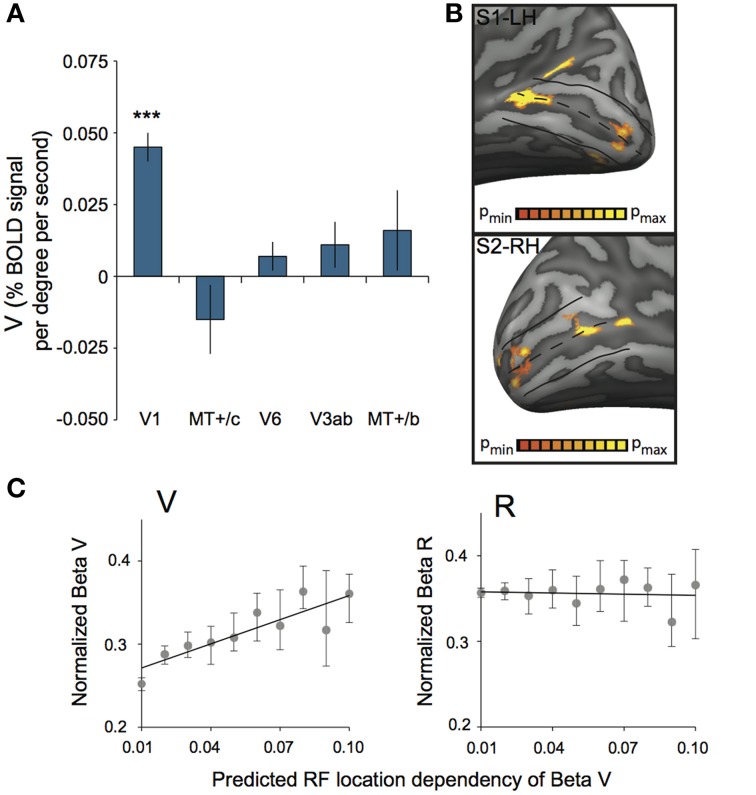
Vergence (V) response in striate cortex. (A) Sensitivity to V across subjects for each ROI. Only V1 was modulated strongly by V (***p < 0.001). (B) V activation plotted on left and right hemisphere of two different subjects, at high significance threshold (p < 0.00001 uncorrected). A clear non-uniform distribution of V sensitivity is observed, resulting in one more foveal and one more eccentric activation blob. (C) Normalized beta plot of median voxel sensitivity to V (βv, left graph) or R (βr, right graph), ordered by their predicted RF location dependency (tan(α) * sin(2θ); binned in 10 equi-distant groups). Error bars represent 95% confidence intervals of the median for each bin, obtained by a bootstrap procedure (1000 samples per bin). The black line in both graphs illustrates the linear model fit. There is a significant linear relation between predicted RF location dependency and the βv for V-responsive voxels (Model Rsquare = 0.76, p = 0.001), but not for R-responsive voxels (Model Rsquare = 0.01, p = 0.78).